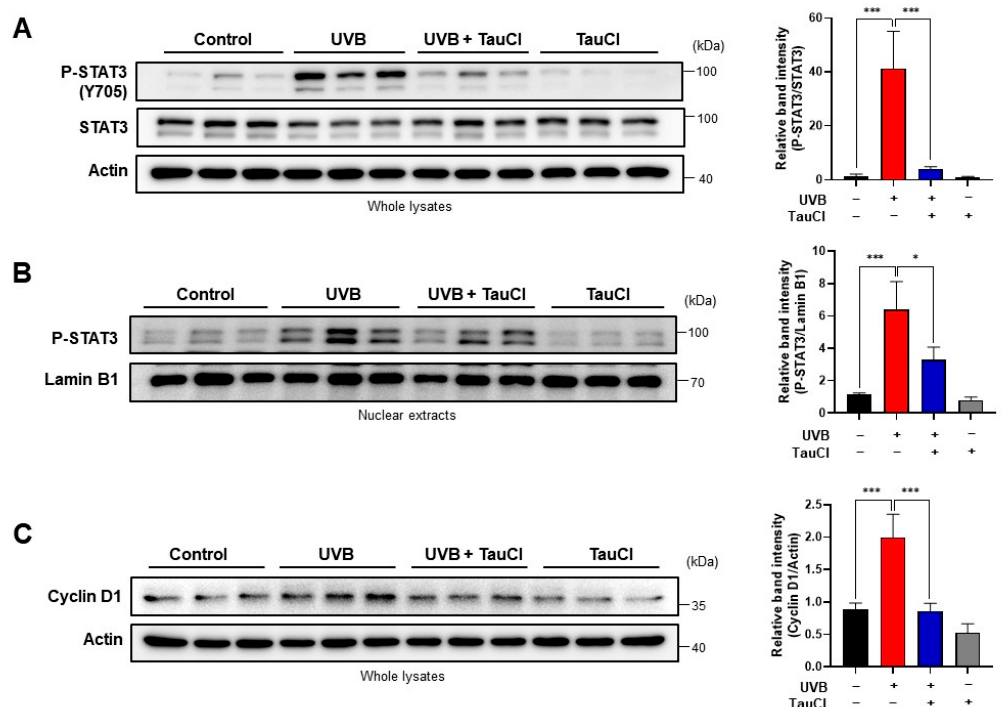
Figure 5. UVB-induced phosphorylation of STAT3 was diminished in TauCl-treated mouse skin. ( A , B ) The expression ( A ) and nuclear accumulation ( B ) of the phosphorylated STAT3 was measured by Western blot analysis. ( C ) The expression of Cyclin D1, a principal target protein of P-STAT3, was measured by Western blot analysis. Actin was used as an equal loading control. Data are expressed as means ± SD ( n = 3 per group), analyzed by one-way ANOVA. * , *** Significantly different between groups compared (* p < 0.05; *** p <